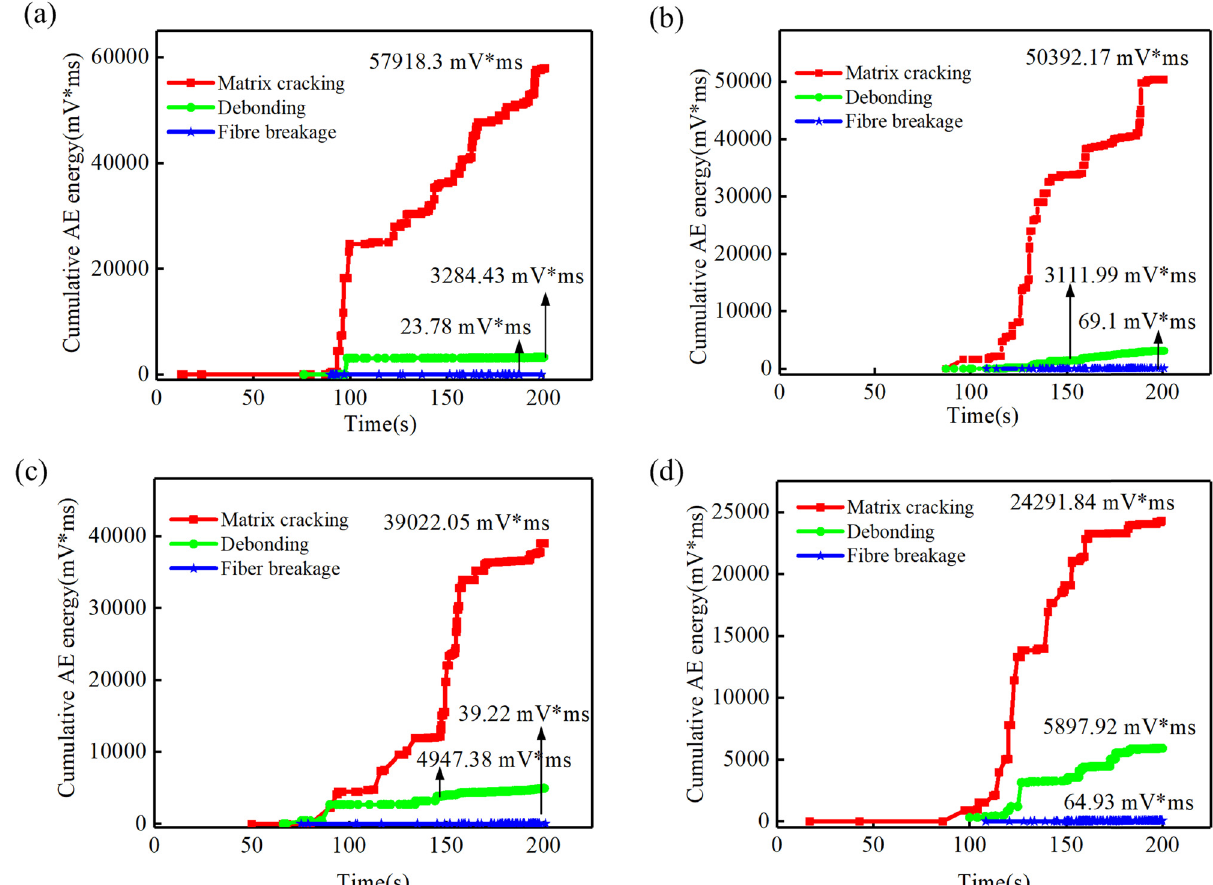
Figure 9: Cumulative AE energy of the four specimens in di ff erent failure modes: ( a ) – ( d ) Specimens A –